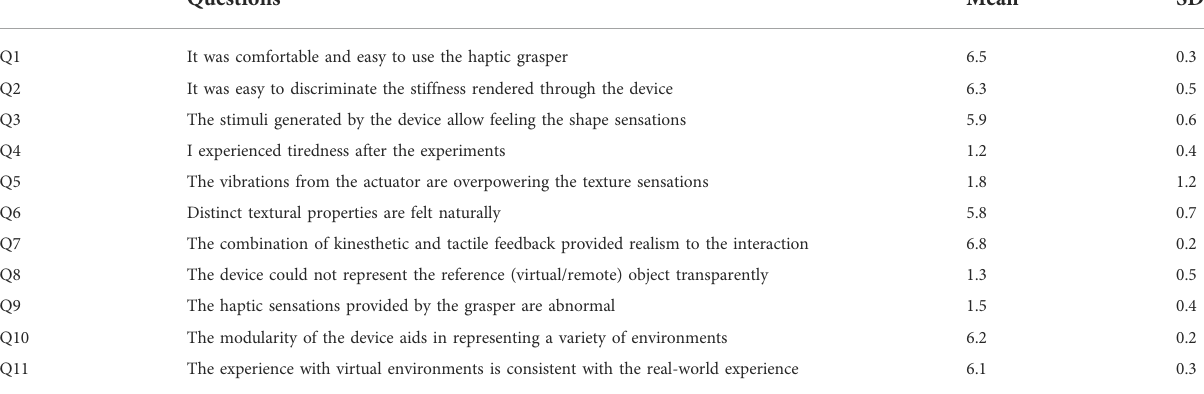
TABLE 5 Questionnaire for User Evaluation using Likert seven-point